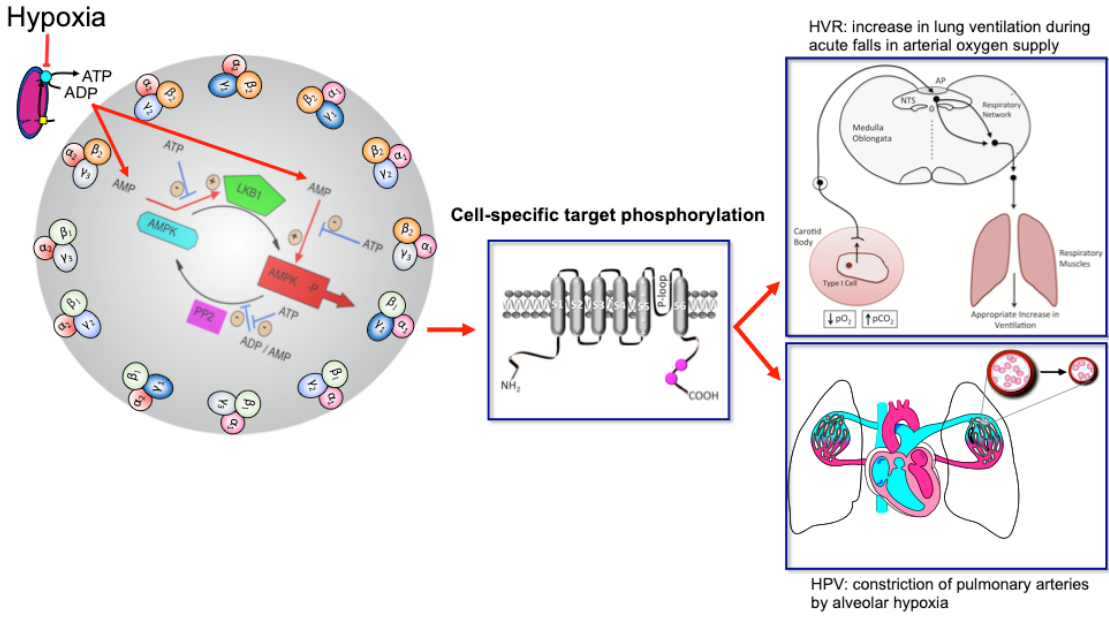
Figure 1. Turn the AMP up to 11 and breathe. Schematic shows the mechanism by which increases in the cellular AMP:ATP and ADP:ATP (adenosine monophosphate and diphosphate to adenosine triphosphate) ratios may activate up to 12 AMPK heterotrimeric subunit combinations, leading to target phosphorylation and induction of the hypoxic ventilatory response (HVR) and hypoxic pulmonary vasoconstriction (HPV). Red arrows indicate pathways leading to AMPK activation by hypoxia, flat heads indicate inhibition, arrow heads indicate activation. Blue arrows with flat heads indicate inhibitory pathways that contribute to the regulation of AMPK activity. Black arrows indicate direction of flow for subordinate pathways. Created by Evans and Hardie.